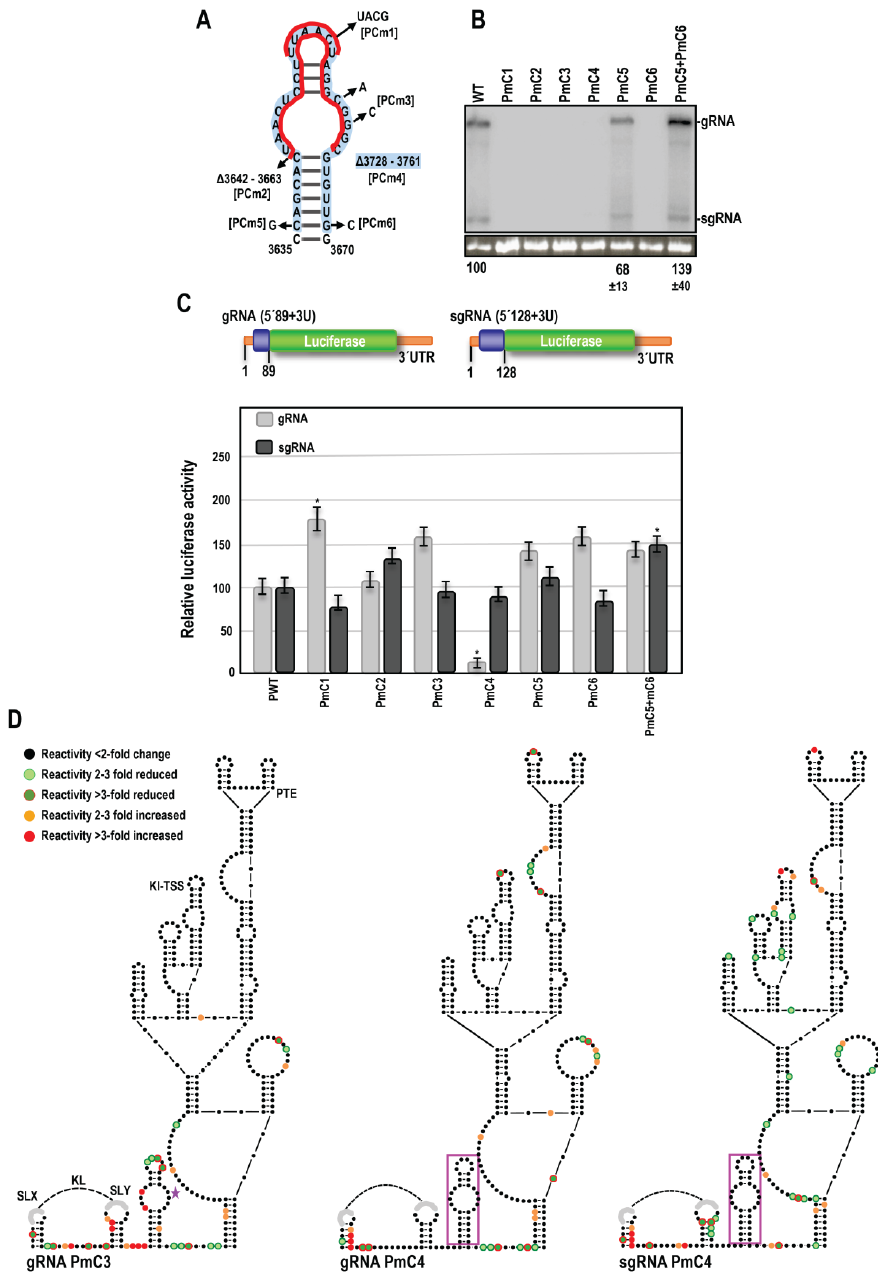
Figure 9. PEMV2 CAS is important for virus accumulation and efficient translation of the gRNA reporter construct. ( A ). Locations of mutations in the CAS hairpin. Names of mutations are bracketed. Red lines indicate some of the nucleotides that were altered or deleted. Blue shading denotes residues deleted in PmC4. ( B ). RNA gel blot analysis of total RNA extracted from systemically infected N. benthamiana leaves following agroinfiltration with either PEMV2 WT or derived CAS mutants. Ethidium bromide-stained 26S rRNA was used as a loading control for normalizing band intensities. ( C ). PEMV2 reporter constructs containing complete 3 (cid:48) UTR and 5 (cid:48) end non-coding (orange) and coding (blue) sequences as previously described [27]. Relative luciferase activity of constructs was assayed in protoplasts. Error bars denote standard deviation for three independent assays. ‘*’ Denotes statistical difference with p < 0.05 analyzed using the t -test. ( D ). SHAPE RNA structure probing of PEMV2 gRNA and sgRNA CAS mutants. Dot colors represent changes in nucleotide reactivity in the mutant construct relative to WT (see legend to Figure 5). Star indicates position of the